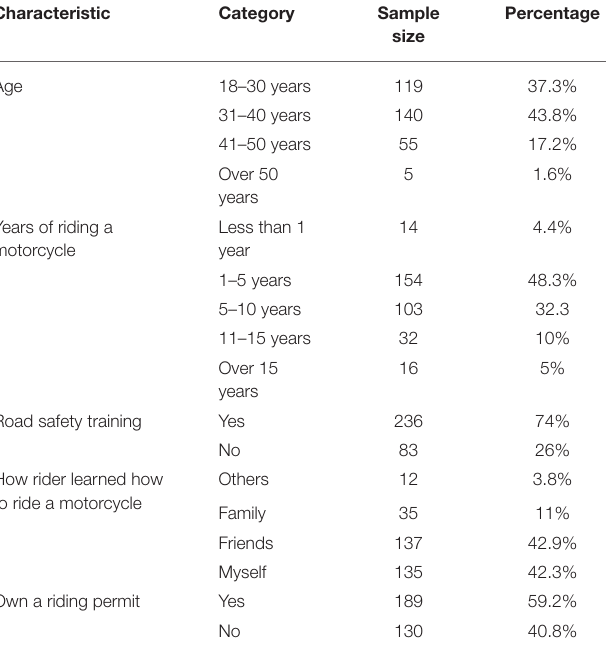
TABLE 2 | General characteristics of the